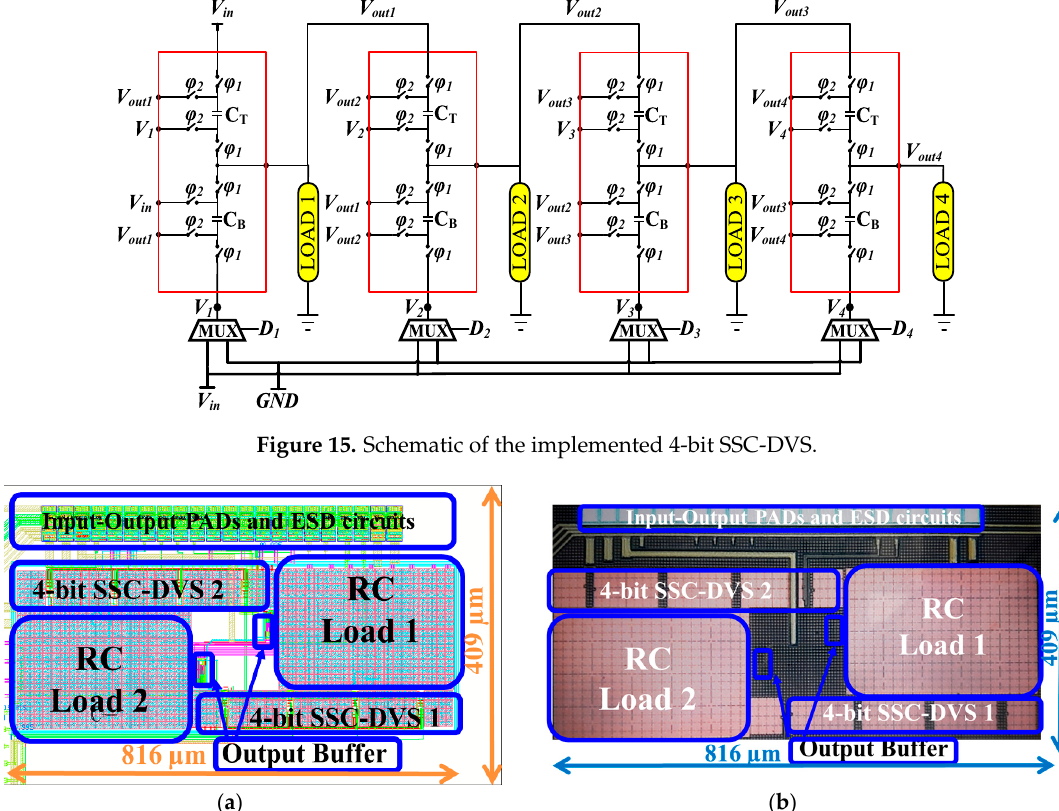
Figure 17. The simulation and post-simulation results of the output voltage levels of the proposed SSC-DVS.